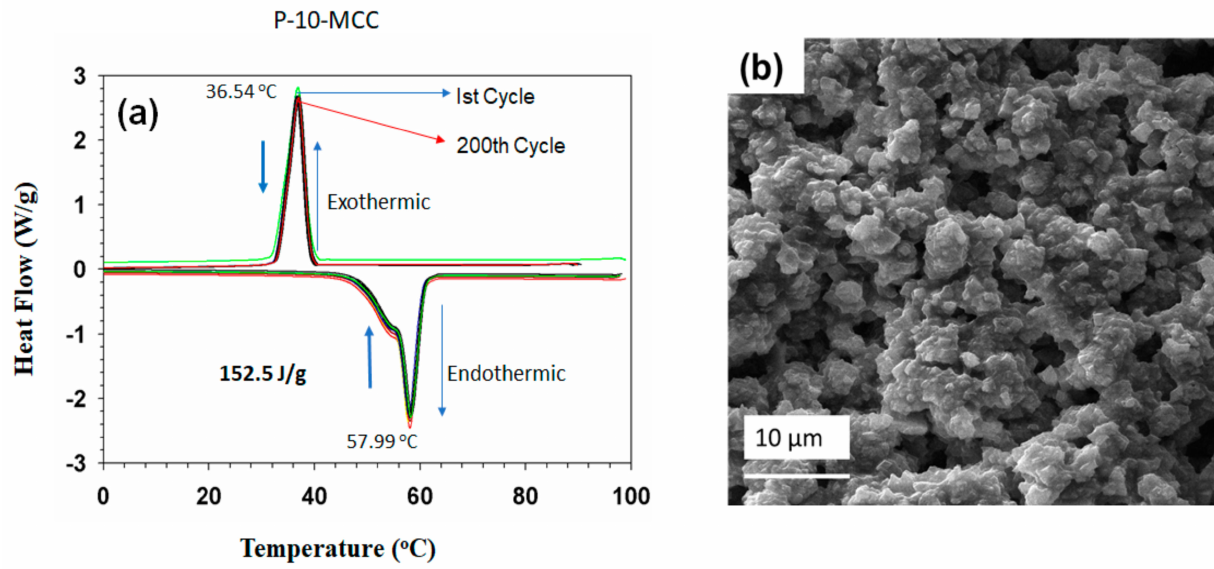
Figure 11. ( a ) Melting–freezing DSC cycling curves of P-10-MCC PCM samples and ( b ) the FE-SEM image, repeated 200